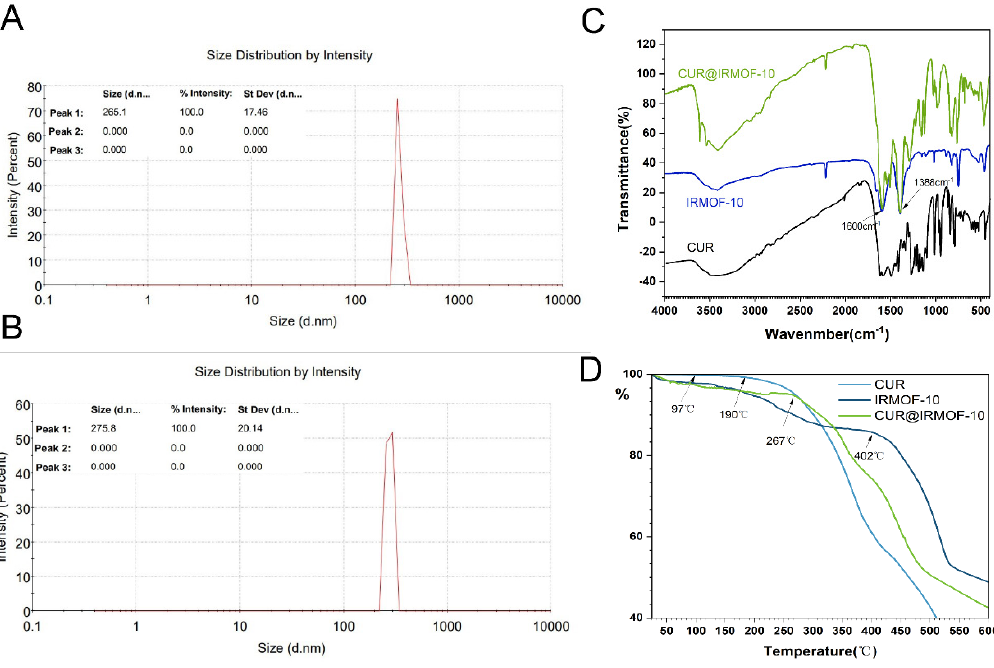
Figure 4. Particle size distribution of ( A ) IRMOF-10 and ( B ) CUR@IRMOF-10; ( C ) Fourier transform infrared spectrometer (FTIR) spectra of IRMOF-10 and CUR@IRMOF-10; ( D ) thermogravimetric (TG) analysis of IRMOF-10 and CUR@IRMOF-10.